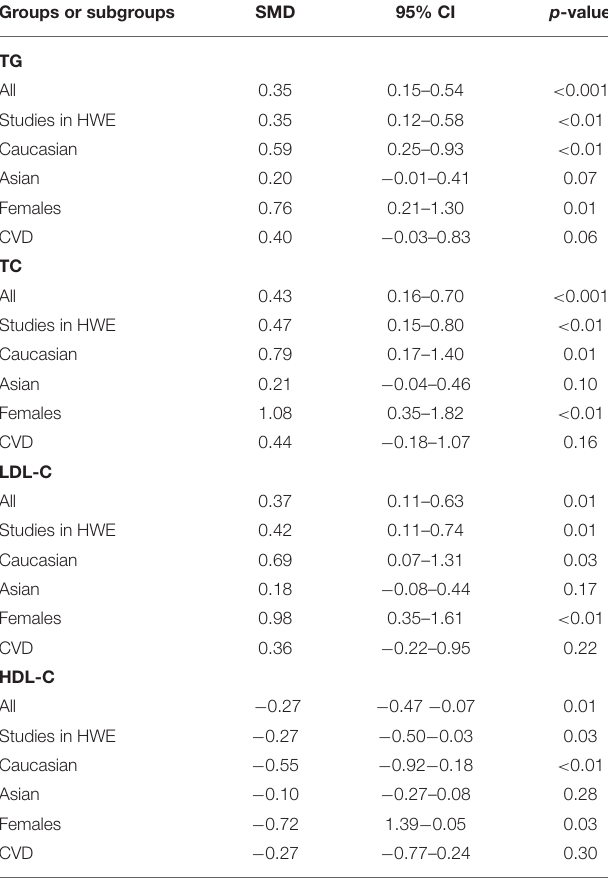
TABLE 1 | Meta-analysis of the miRNA-146a rs2910164 polymorphism with lipid